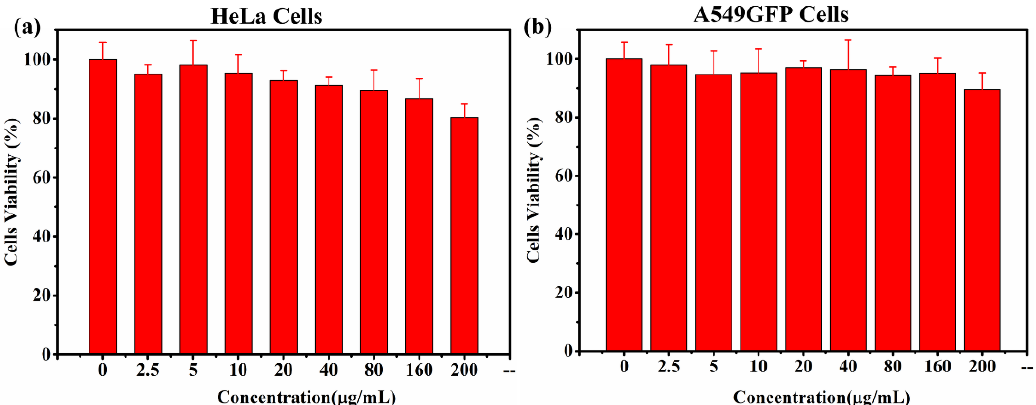
Figure 4. ( a ) Viabilities of HeLa cells and ( b ) A549GFP cells incubated with CFS-S at different con- centrations for 24 h.